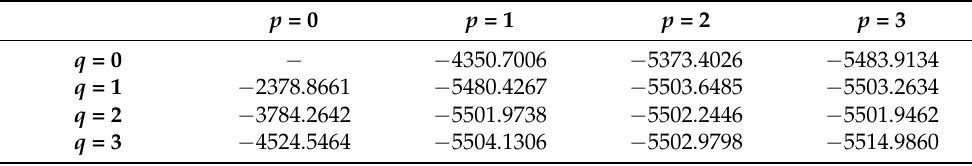
Table A7. AIC values of x -axis BiLSTM network results at each order.